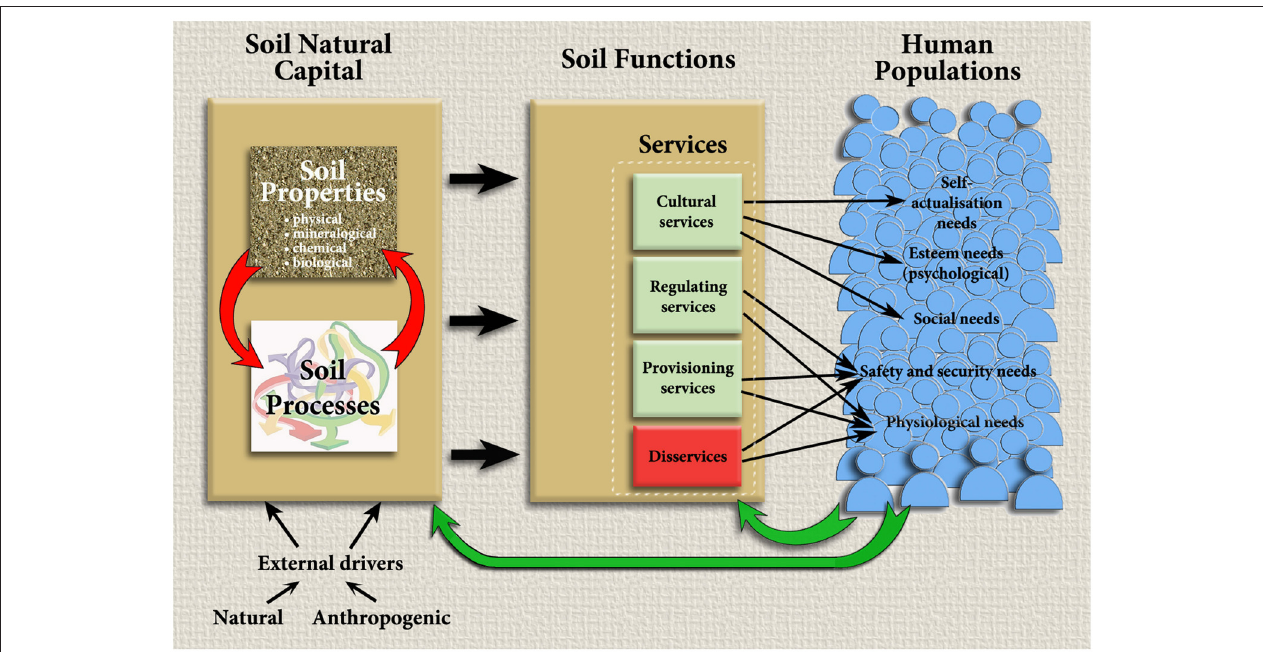
FIGURE 6 | Schematic diagram depicting the relation between soil properties and processes (jointly constituting the soil “capital,” under the influence of a number of external drivers), soil functions (including soil services and disservices as subsets), and human well-being.